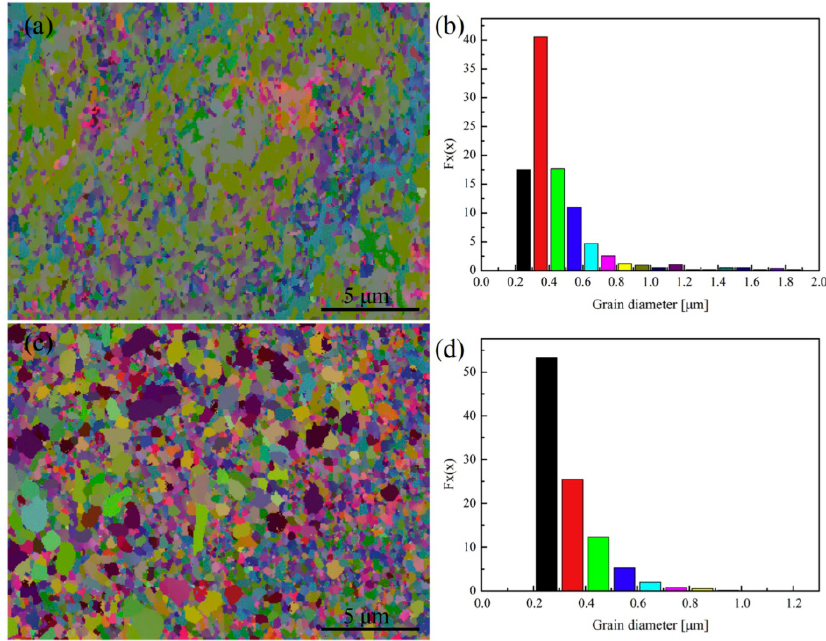
Figure 18. EBSD images and copper grain-size distribution of as-cast TiB2p(–TiBw)/Cu and TiB2p(– TiBw)/Cu–La composites: ( a , b ) the as-cast TiB2p(-TiBw)/Cu; ( c , d ) the as-cast TiB2p(-TiBw)/Cu–La composites [23]. Reprinted/adapted with permission from Ref. [23]. Copyright year 2020, Elsevier.